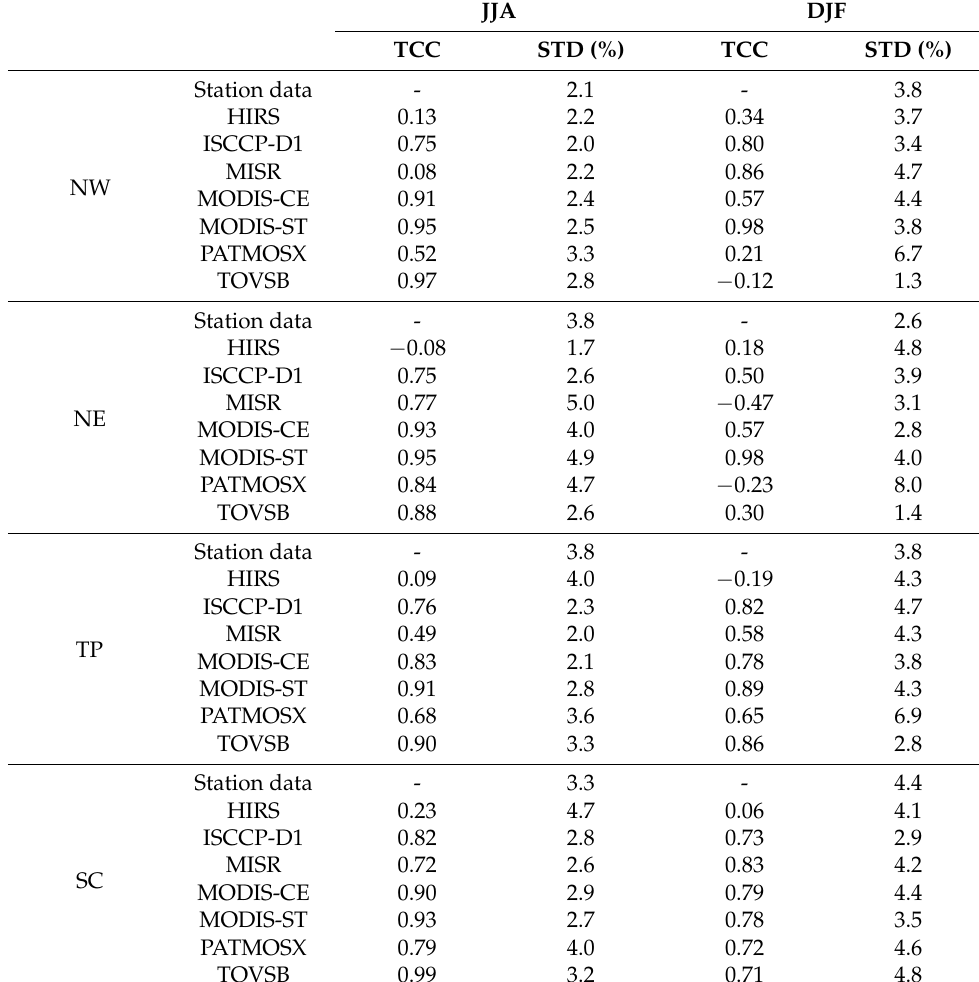
Table 4. The temporal correlation coefficients (TCC) of the TCA between the satellite datasets and station data over NW, NE, TP, and SC regions of China in summer and winter, respectively. The STD represents the interannual variability of TCA for each